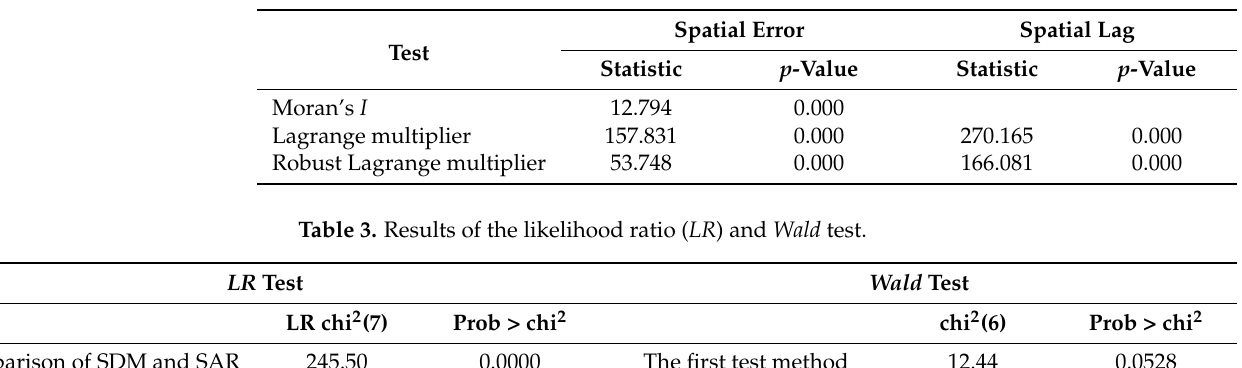
Table 2. Results of the Lagrange multiplier ( LM ) test.